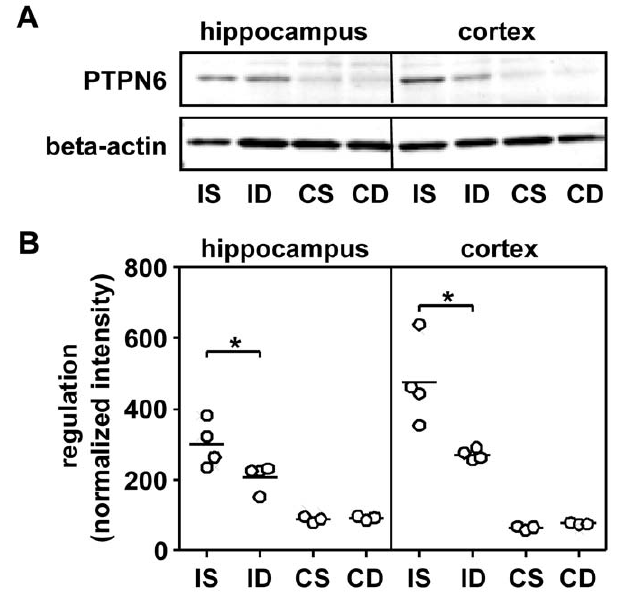
Figure 7. Western blot and microarray assessment of tyrosine phosphatase, non-receptor type 6 (PTPN6). The western blot analysis showed increased protein levels in hippocampus and cortex homogenates of infected animals compared to control samples (A). This finding confirms the results of the microarray experiment (B). I=infected animals, S=saline treatment, D=dexamethasone treatment, C=control animals.